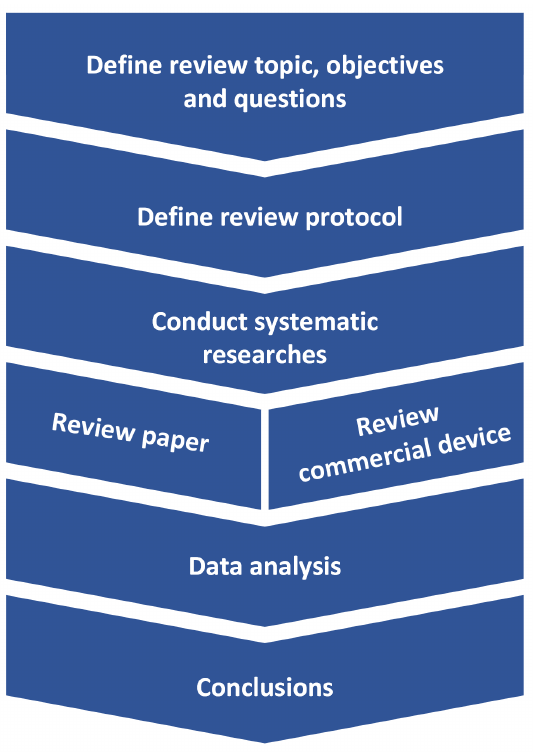
Figure 1. Process followed in this